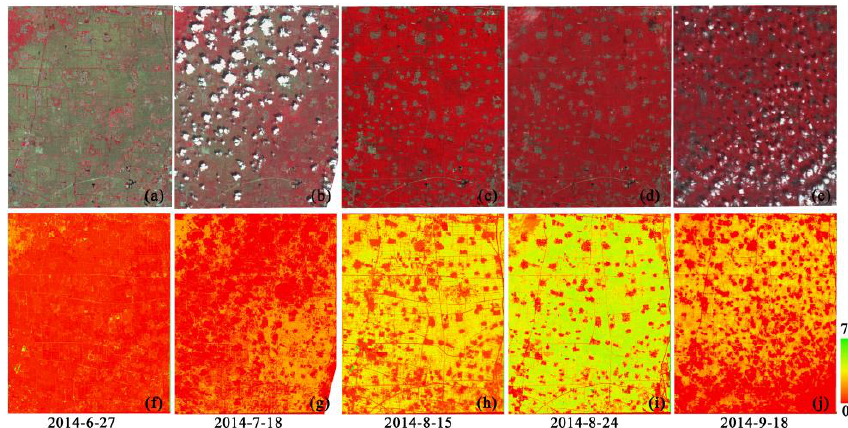
Figure 5. GF-1 WFV land surface reflectance data (( a ) 27 June 2014, ( b ) 18 July 2014, ( c ) 15 August 2014, ( d ) 24 August 2014, and ( e ) 18 September 2014) and their corresponding LAI estimates (( f ): 27 June 2014, ( g ) 18 July 2014, ( h ) 15 August 2014, ( i ) 24 August 2014, and ( j ) 18 September 2014).